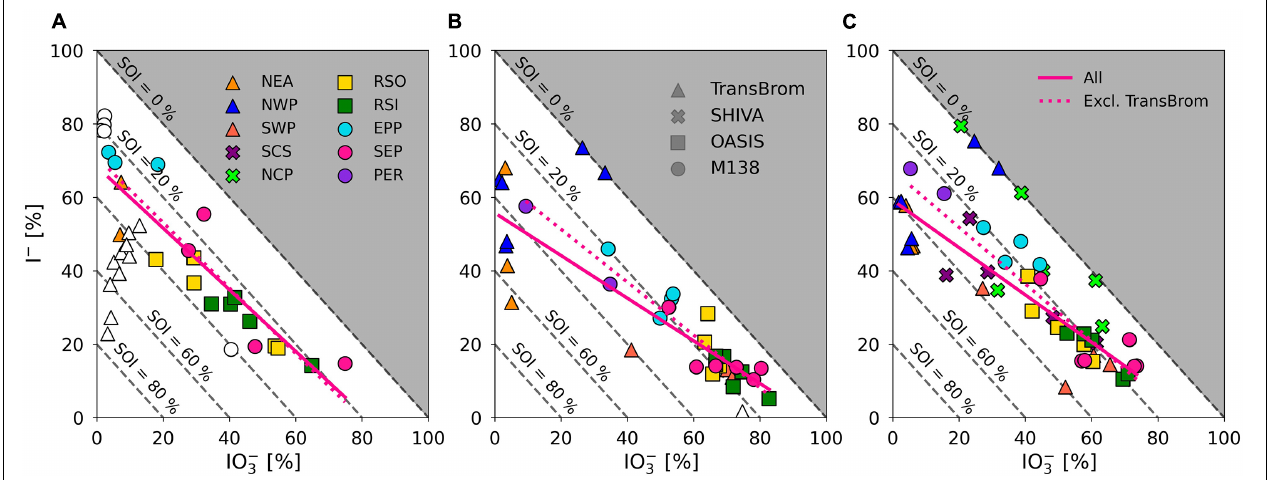
FIGURE 7 | Percentage I - and IO 3 - of TSI plotted against each other for fine mode (A) and coarse mode (B) , aerosol samples on the TransBrom, OASIS, and M138 expeditions, and bulk/total (C) aerosol samples collected on the TransBrom (triangles), OASIS (squares), M138 (circles), and SHIVA (crosses) expeditions. Colour of markers corresponds to the air mass type associated to the sample (also see Figure 2 ). Empty markers indicate samples for which I - or IO 3 - concentrations were below the detection limit. Linear regression lines are plotted for all fine, coarse, or bulk/total samples (solid) and all samples excluding those from the TransBrom expedition (dotted). Dashed diagonal lines indicate percentage of SOI of TSI. Samples for which concentrations were below the detection limit and samples where SOI < 0 are excluded from the linear regressions.